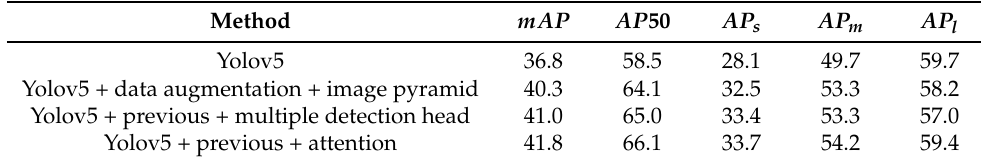
Table 5. Ablation studies on the Visdrone2019 validation